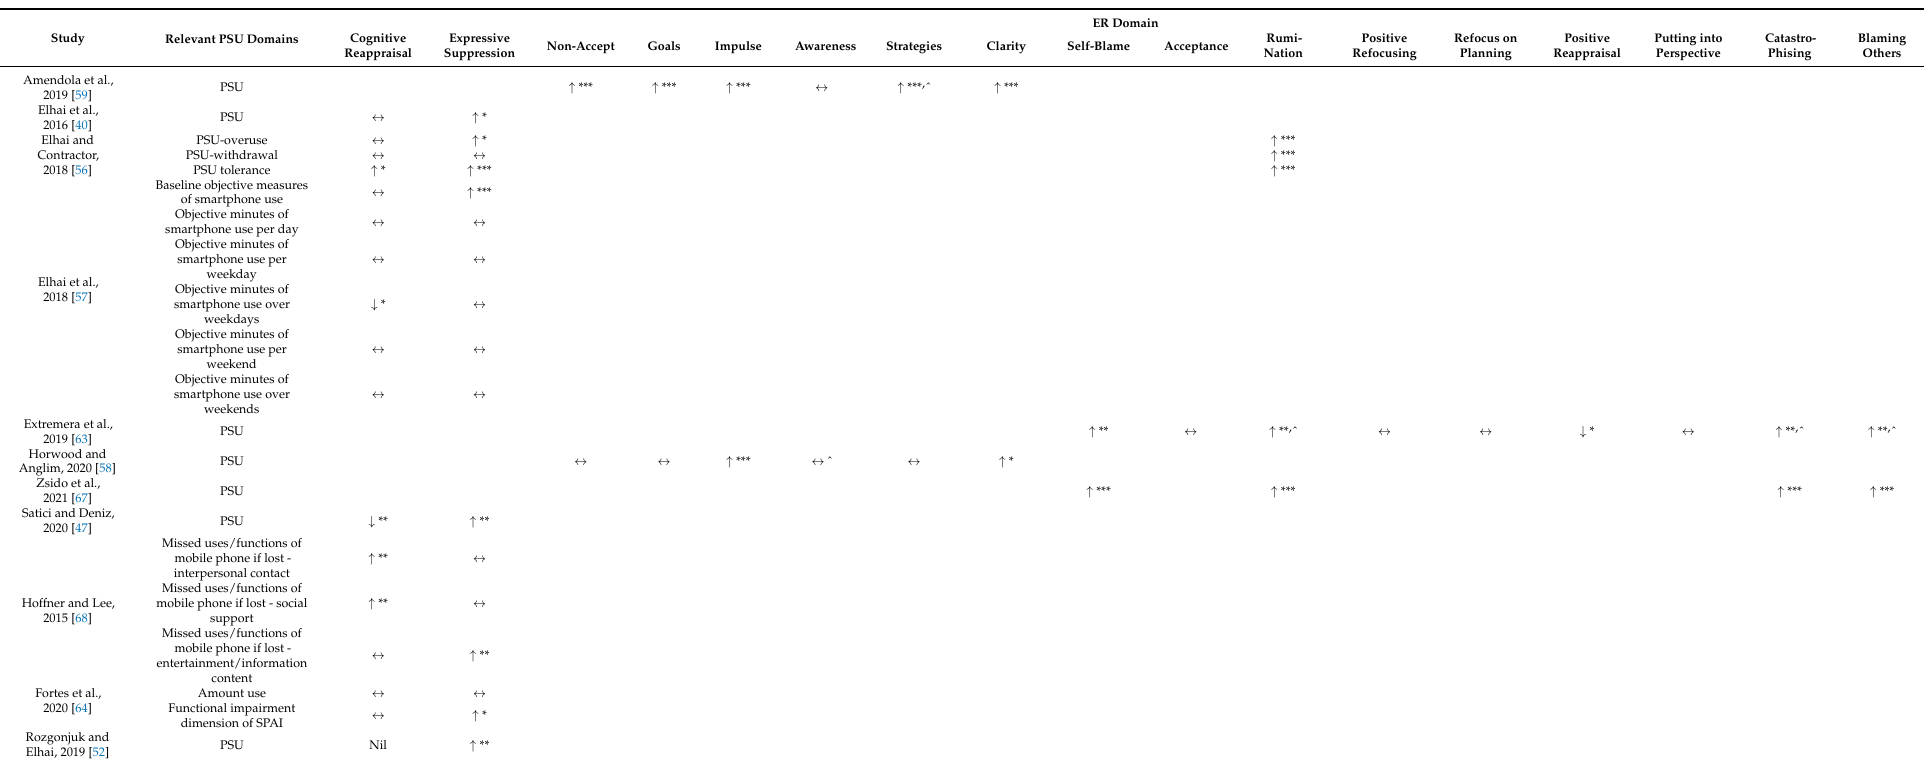
Table A3. Summary of PSU on ER domain